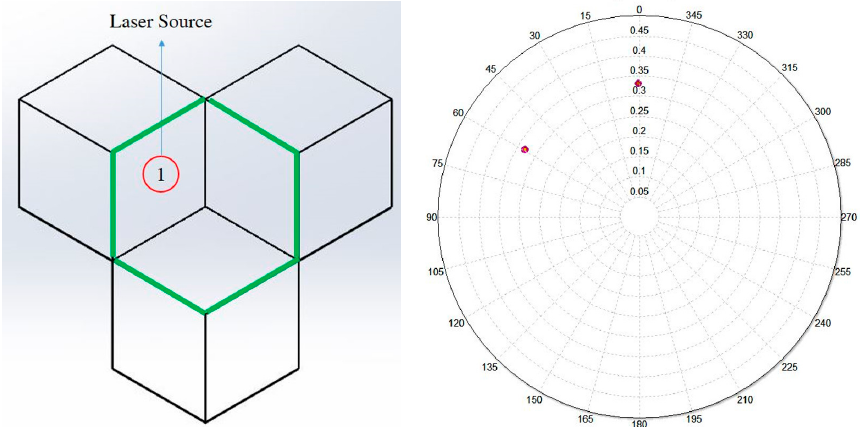
Figure 13. CCCR #1 reflecting surface in the posterior region is hit by simulated laser beam ( left ) and the resulting retroreflected light intensity distributions ( right ).